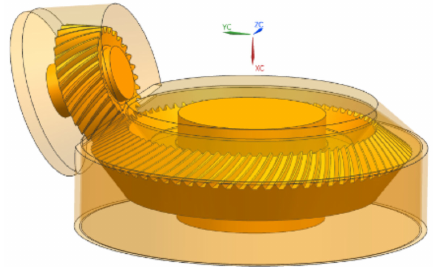
Figure 1. Three-dimensional model of spiral bevel